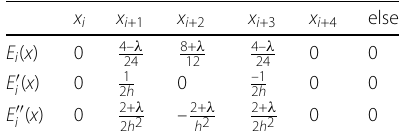
Table 1 Coefficients of extended cubic basis E i ( x ) and its derivatives at different knots x i x i +1 x i +2 x i +3 x i